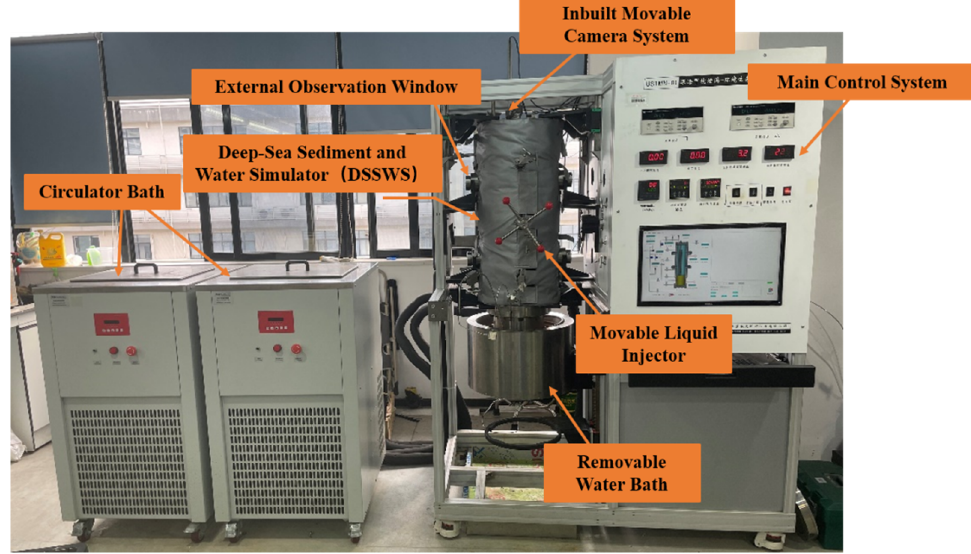
Figure 1. Physical diagram of the experimental system.